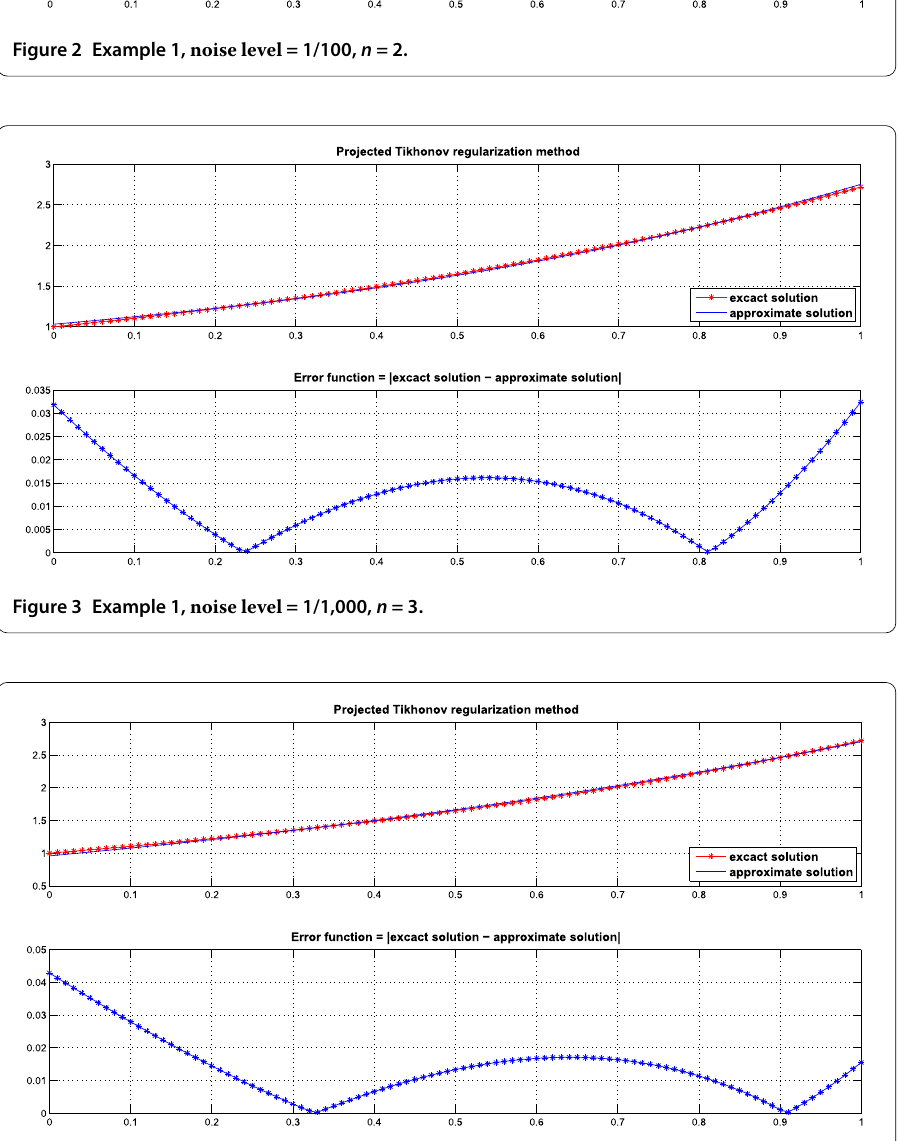
Figure 4 Example 1, noise level = 1/100, n =